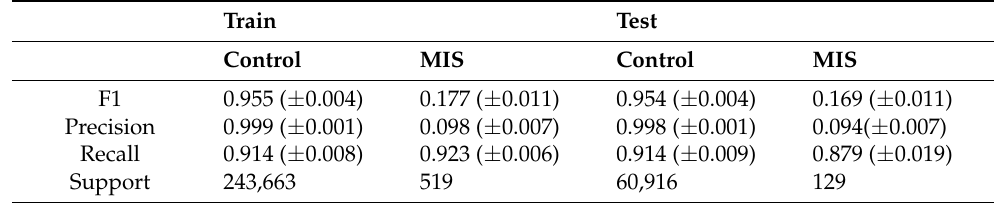
Table A2. Logistic regression performances.